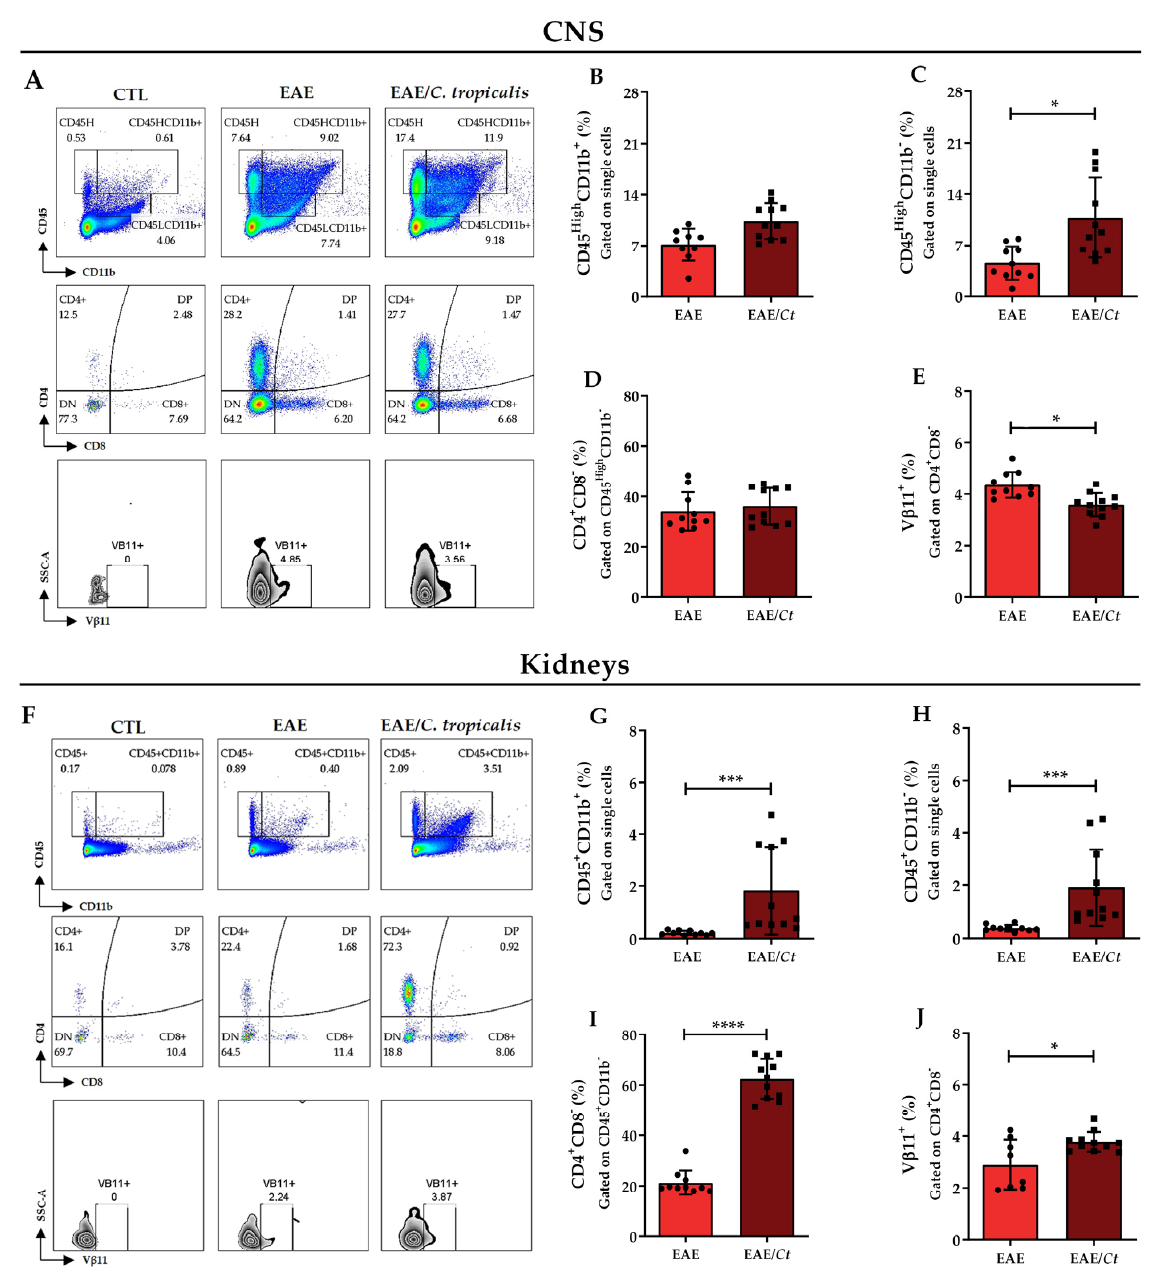
Figure 9. Leukocyte subpopulations in the CNS and kidneys of EAE and EAE/Ct mice. Female C57BL/6 mice were infected with 1 × 10 6 viable C. tropicalis yeasts three days before EAE induction and evaluated for the percentage of myeloid cells (CD45 High CD11b + ), other immune cells (CD45 High CD11b − ), CD4 + cells (CD4 + CD8 − ), and TCR expression (V β 11 + ) in the CNS ( A – E ) and kidneys ( F – J ) on the 16th day after EAE induction. Representative flow cytometric plots for leukocyte popula- tions in the CNS ( A ) and kidneys ( F ). The results are expressed as mean ± SD; n = 10–11/group; two independent experi- ments; * p < 0.05; *** p < 0.005, and **** p < 0.001. Additionally, the expression of transcription factors associated with T helper (Th) 1, Th2, Th17, and regulatory T cells (Treg) was evaluated in the lumbar spinal cord and kid- neys. A significant decrease was observed in the relative mRNA expression of Tbx21